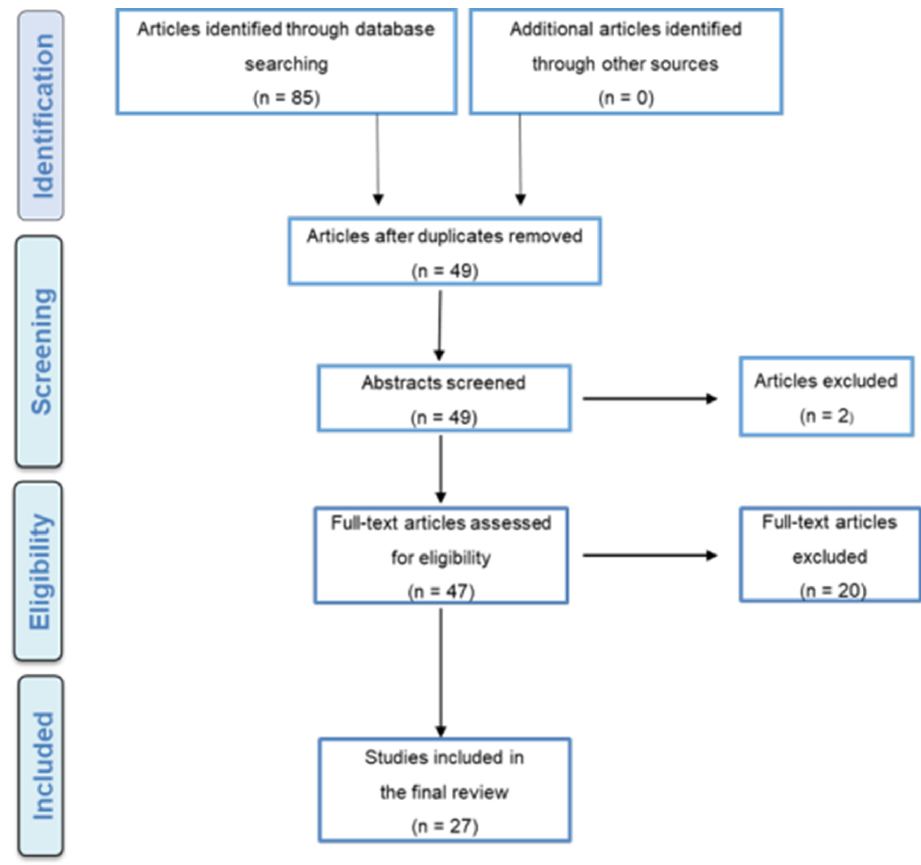
Figure 2. Flow diagram of the selection process.